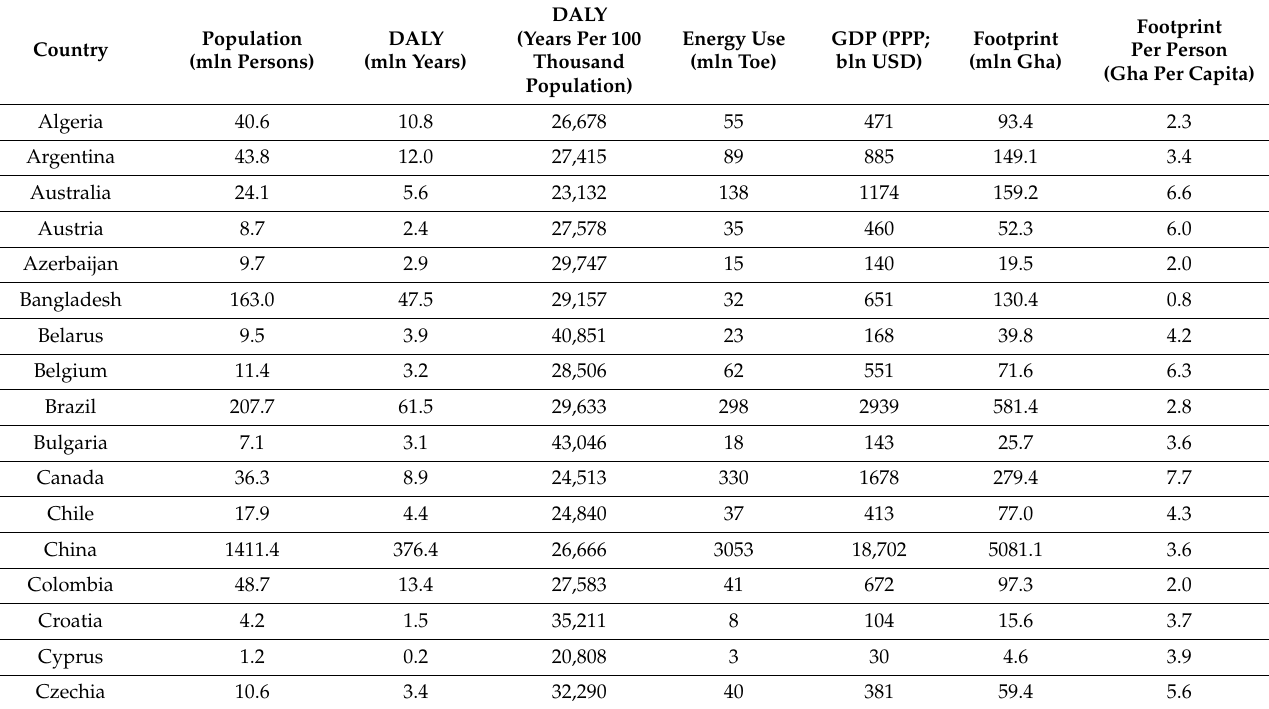
Table A1. Basic statistics for